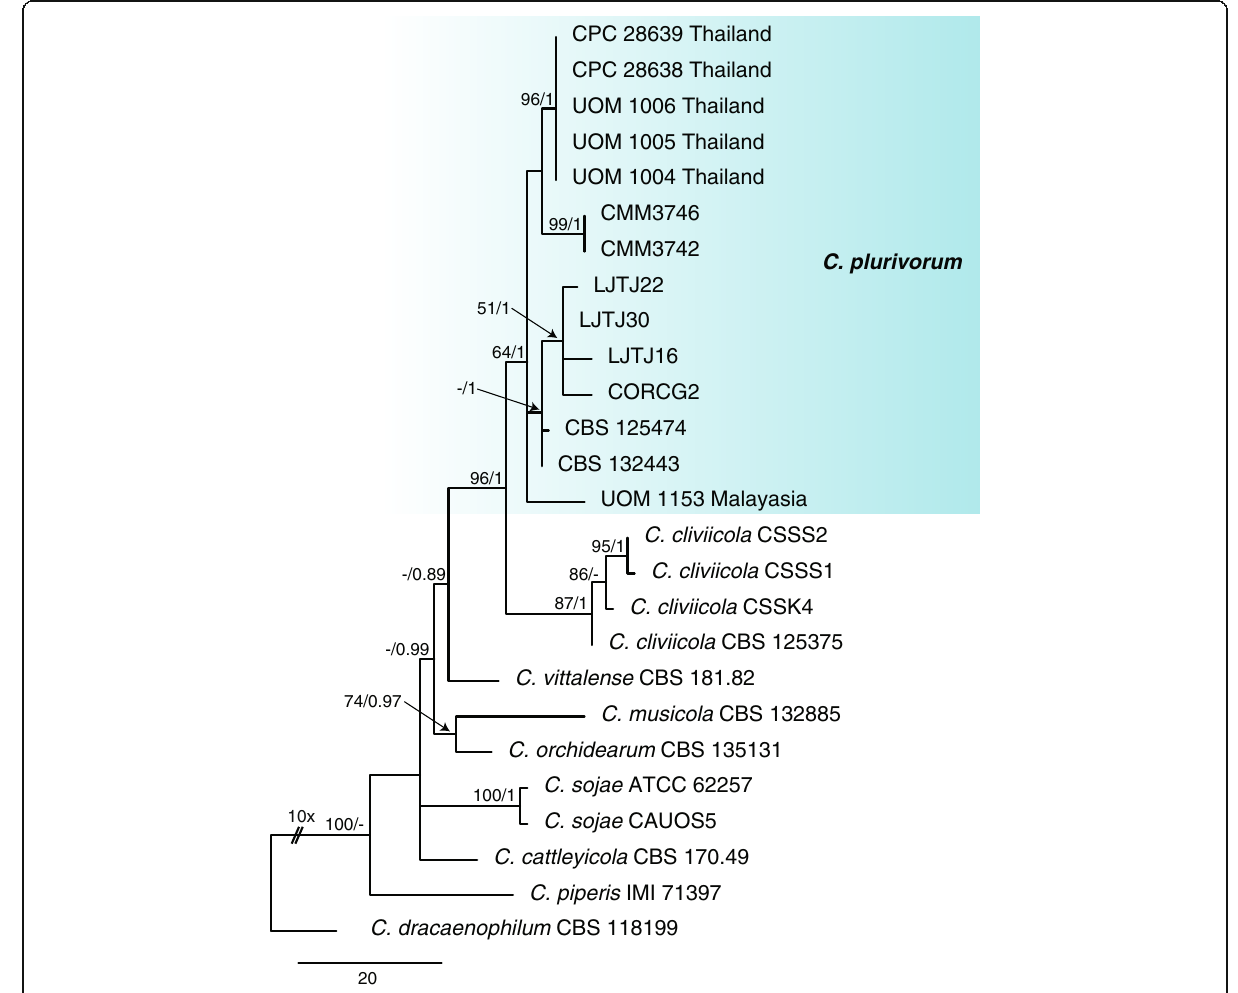
Fig. 5 First of 284 equally most parsimonious trees obtained from a heuristic search of the combined ITS, tub2 , gapdh , chs-1 , and act sequence alignment of the Colletotrichum isolates in the orchidearum complex. The parsimony bootstrap support values (MP > 49%) and Bayesian posterior probabilities (PP > 0.90) are displayed at the nodes (MP/PP). The tree was rooted to C. dracaenophilum (CBS 118199). The scale bar indicates 20 changes. Coloured blocks are used to indicate clades containing isolates from